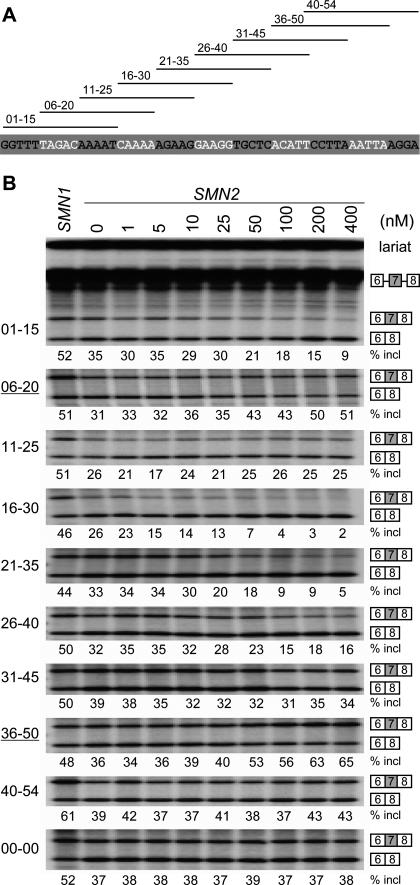
Initial ASO Walk along Exon 7, Assayed by In Vitro Splicing(A) Schematic representation of the binding sites for the nine MOE ASOs used in the initial exon 7 walk. The position of complementarity of each ASO along exon 7 is indicated by a horizontal line.(B) Effect of ASOs on in vitro splicing of SMN2 minigene-derived pre-mRNA. Each ASO was tested at the indicated concentrations, and SMN1 pre-mRNA was used as a positive control. The radiolabeled RNAs were analyzed by denaturing PAGE and autoradiography. The diagrams on the right indicate the mobilities of the various RNA species. The percentage of exon 7 inclusion in each lane was calculated as described in Materials and Methods, and is indicated below each autoradiogram. The two ASOs that promote exon 7 inclusion are underlined.